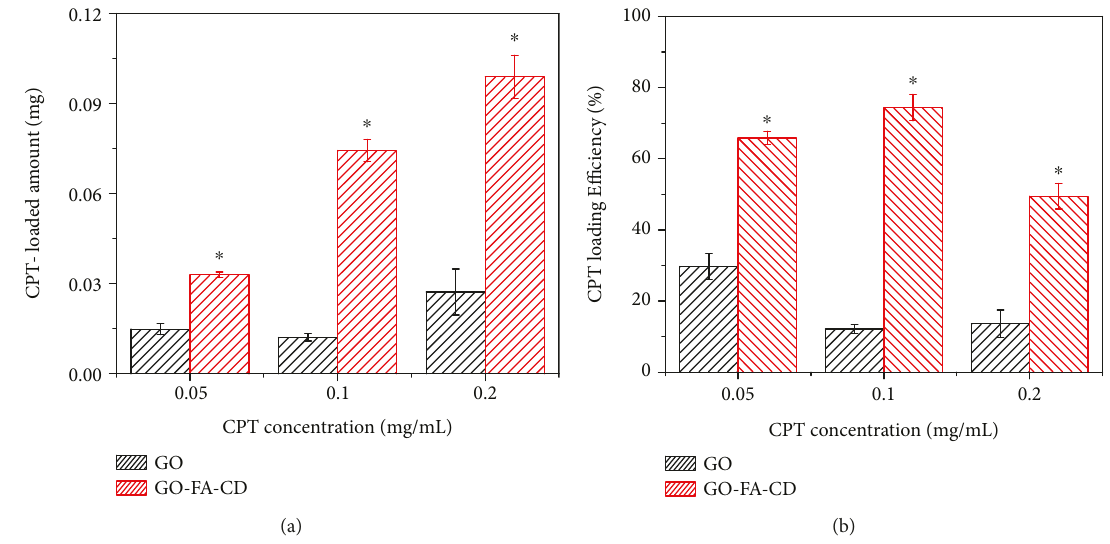
Figure 6: (a) CPT-loaded amount and (b) CPT loading e ffi ciency of GO and